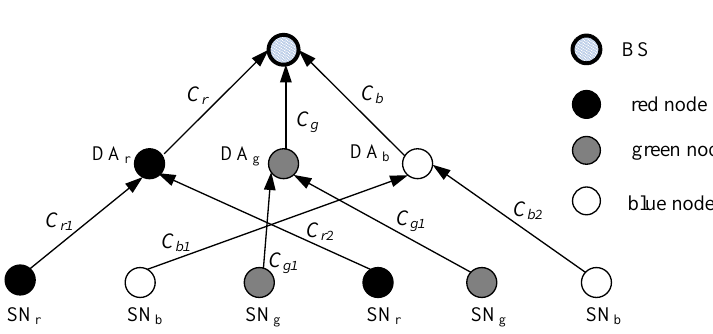
Figure 2. A case study of